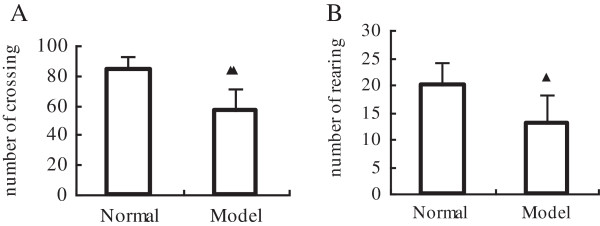
Comparison of behavioral motor effects elicited by acute stress in open-field test. A, Horizontal activity estimated as the number of grids crossed during a 3-minute test. B, The frequency of rearing with hind legs during a 3-minute test. The data were obtained one day before sacrificed. Data are expressed as mean ± SEM (n = 8). ▲P<0.05 and ▲▲P<0.01 compared with the normal group.